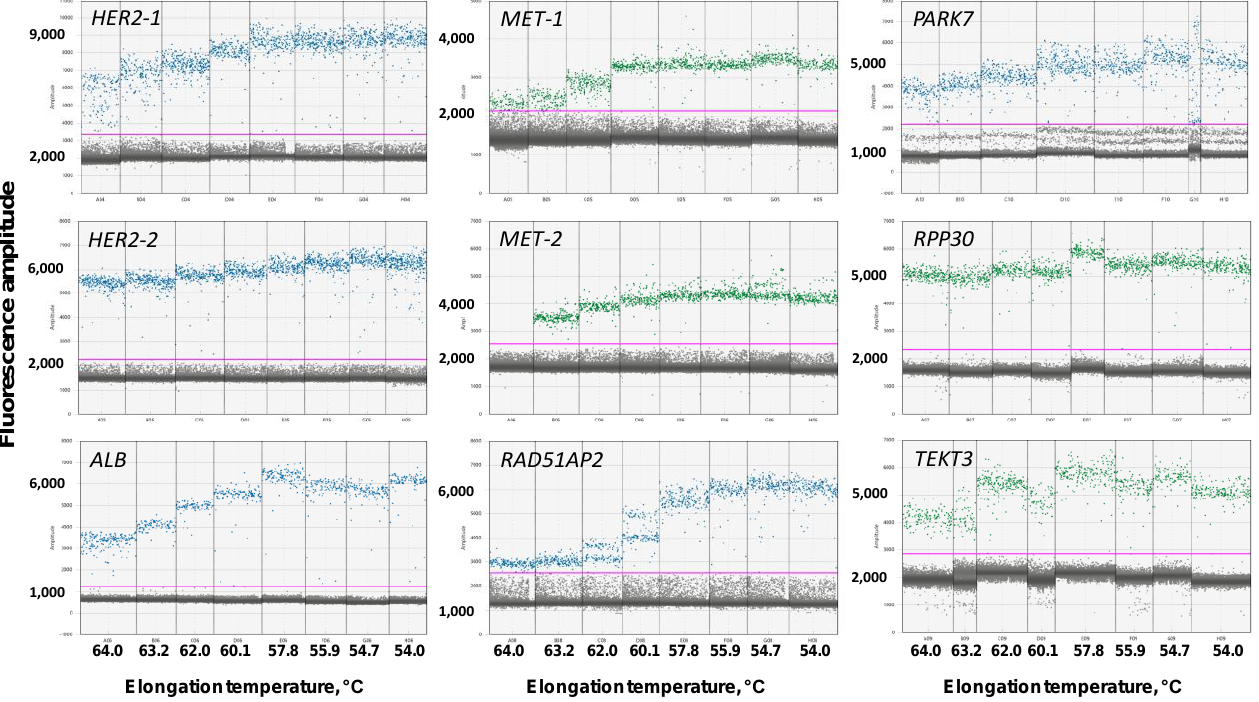
Figure 2. Results of ddPCR with monoplexes. Each panel represents results for the set of primers and probes that are designated at the left upper angle. X-axis marks elongation temperature, Y-axis marks end-point fluorescence.